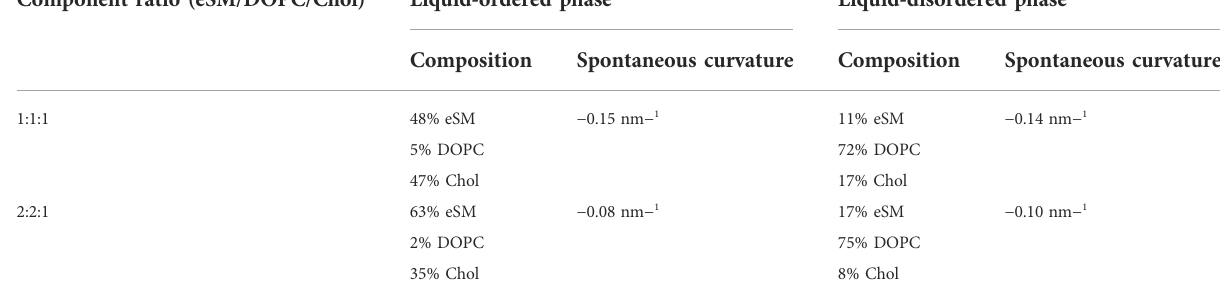
TABLE 1 Phase compositions and spontaneous curvatures. Component ratio